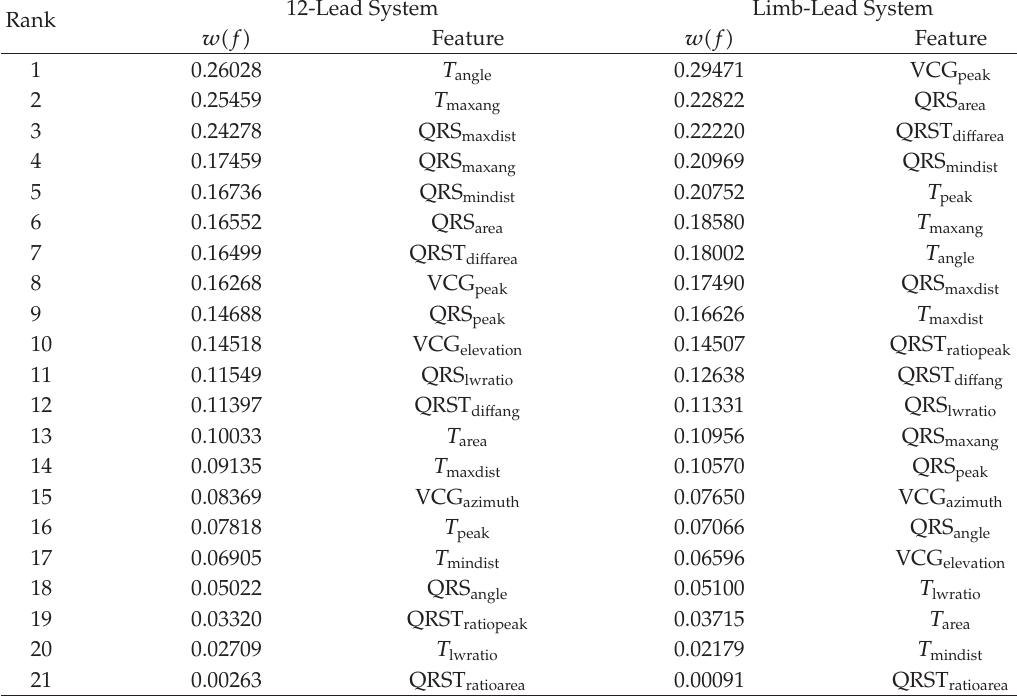
Table 1: Rank for each set of 21 features extracted from dVCGs based on a standard 12-lead and limb-lead ECG,